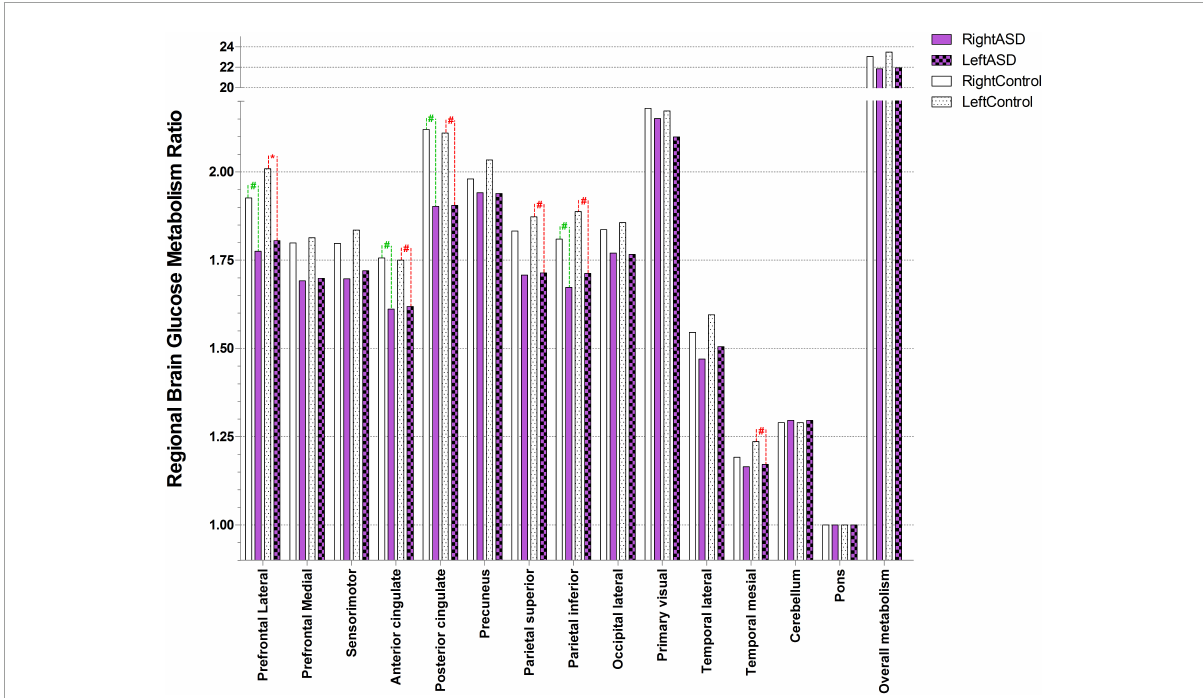
FIGURE2 Ratio of brain glucose metabolism in regions of interest between control and ASD ( * represents statistically significant, # tentative statistically significant by Wilcoxon signed-rank test).